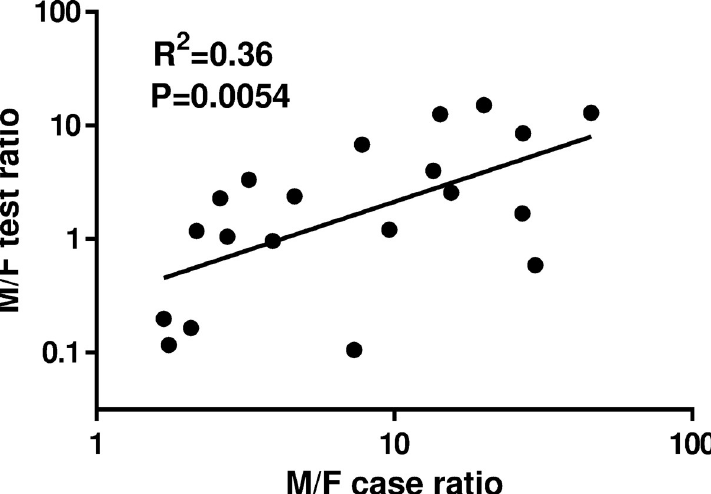
Fig 1. Correlation analysis between the male-to-female (M/F) gonorrhea case ratios and M/F gonorrhea testing ratios in 2018 among hospitals in Zhongshan city, China. Only 20 hospitals were included in the correlation analysis because 4 hospitals did not report any female gonorrhea